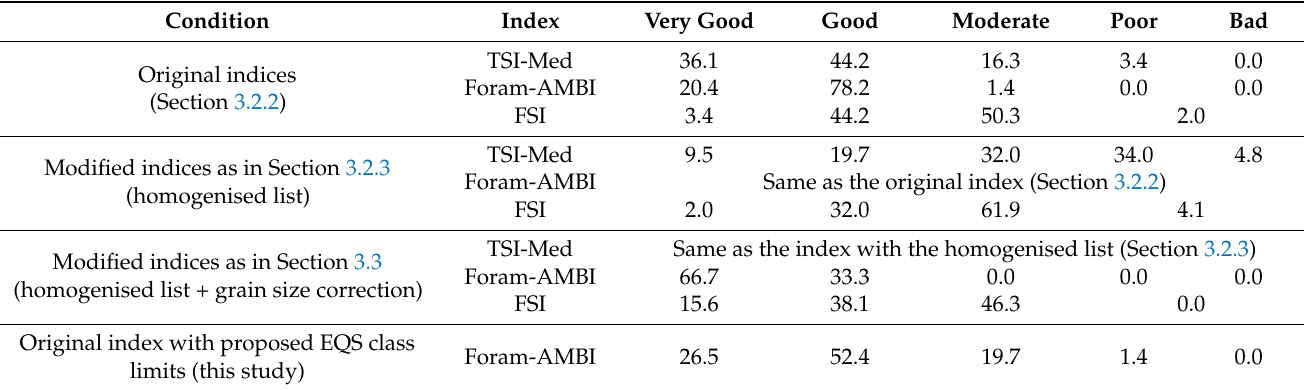
Table 5. Percentages of sites assigned to each EQS classes by the three biotic indices based on groups of indicator species (TSI-Med, Foram-AMBI, and FSI).